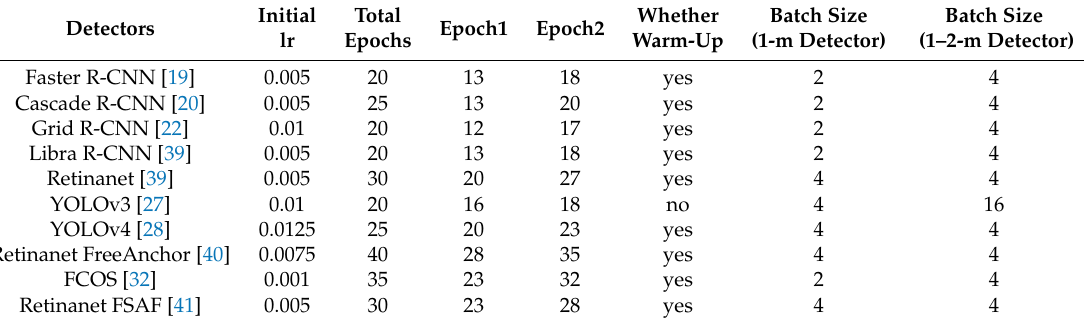
Table 3. Parameter settings in training. Initial lr, initial learning rate; Epoch1 and Epoch2: All detectors utilized the STEP lr decline strategy, and the lr decreased to 0.1 times at Epoch1 and Epoch2; Batch size: 1 m and 1–2 m refer to the resolution of the samples in training